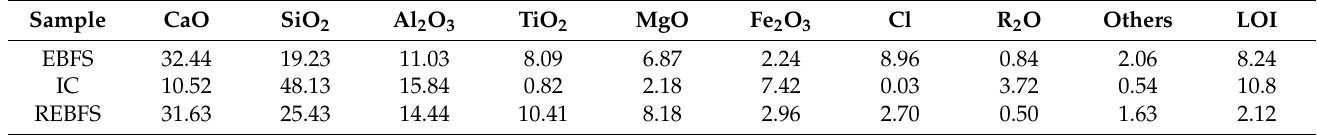
Table 1. Chemical compositions of raw materials (wt. %).